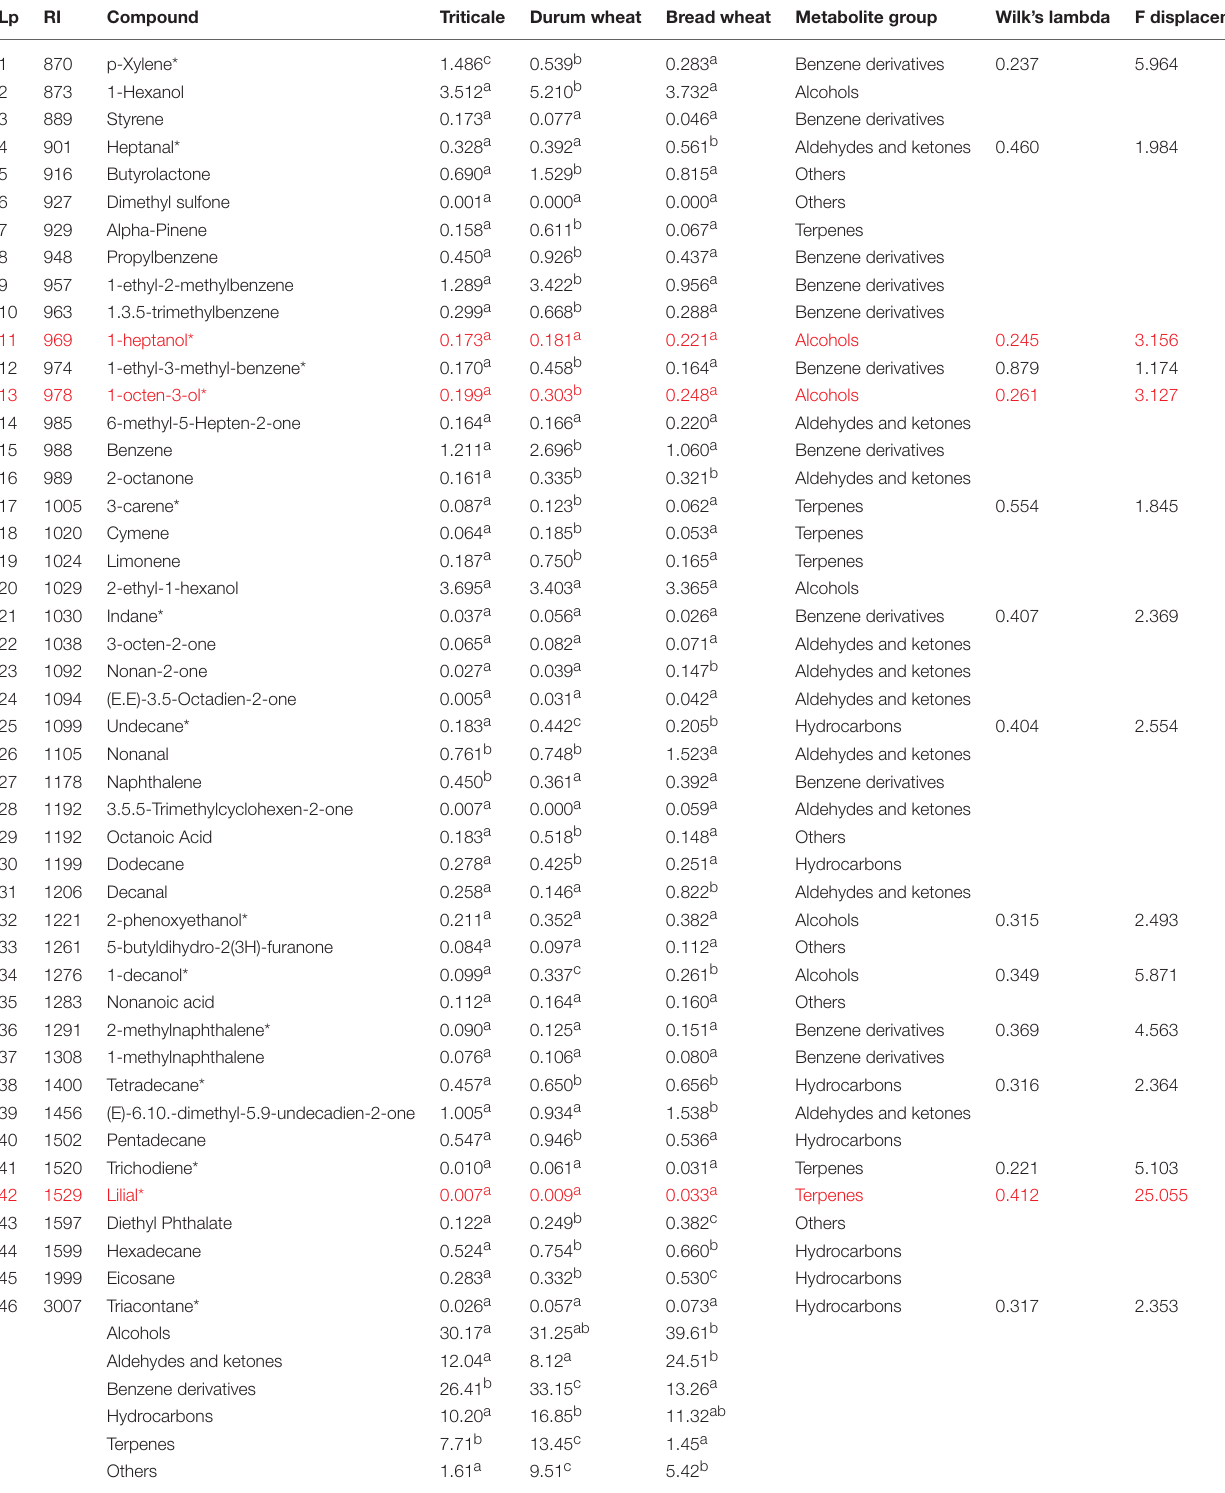
TABLE 3 | Qualitative and quantitative (RU) profile of 46 volatile metabolites for 16 genotypes of triticale, durum wheat, and bread